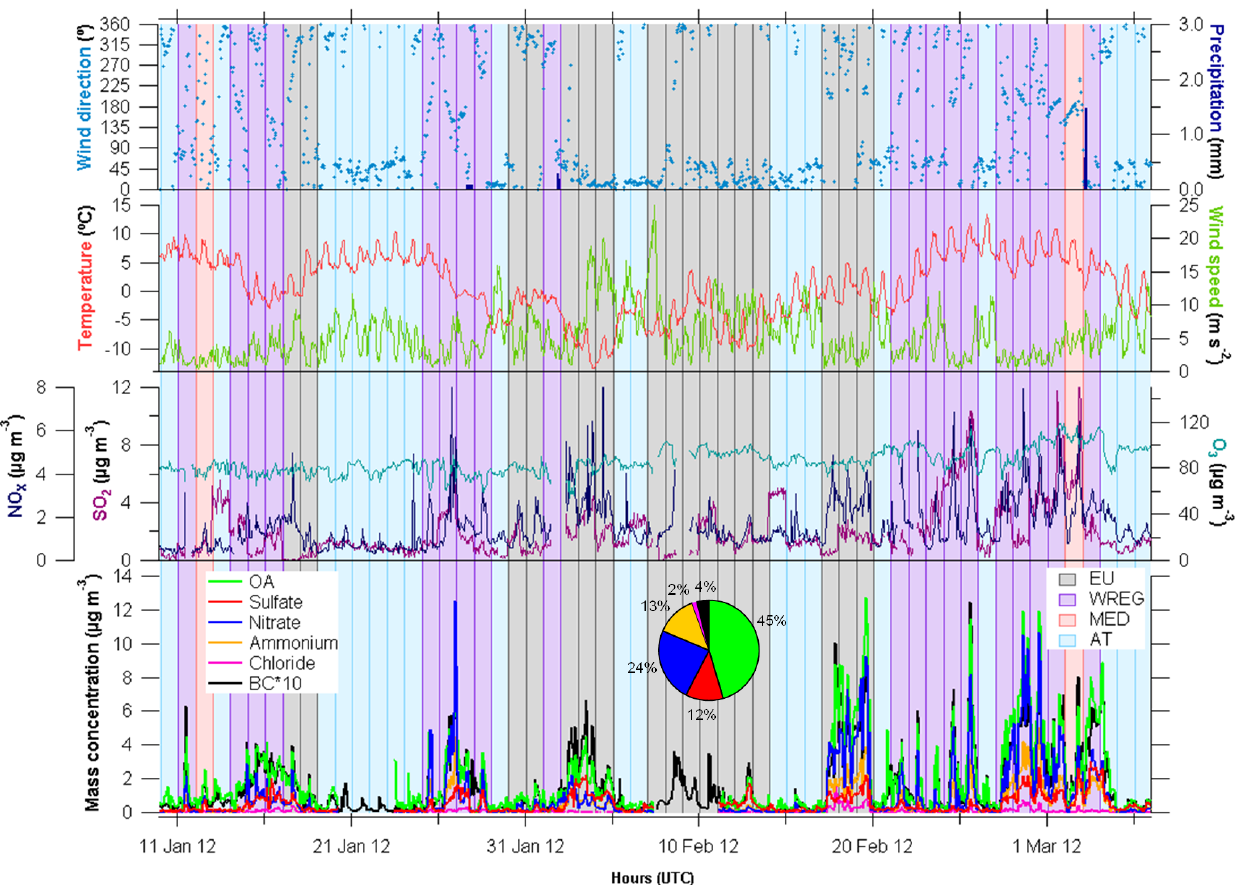
Figure 7. Time series of wind direction (WD) and speed (WS), temperature ( T ), precipitation (PP), concentrations of NO x , SO 2 , O 3 , and PM 1 chemical species (organics, sulfate, nitrate, ammonium, chloride and black carbon (BC)) in winter (10 January 2012–7 March 2012). Background colors correspond to daily classification of atmospheric episodes (European (EU), winter regional (WREG), Mediterranean (MED) and Atlantic (AT)) and the pie chart corresponds to the average chemical composition for the winter